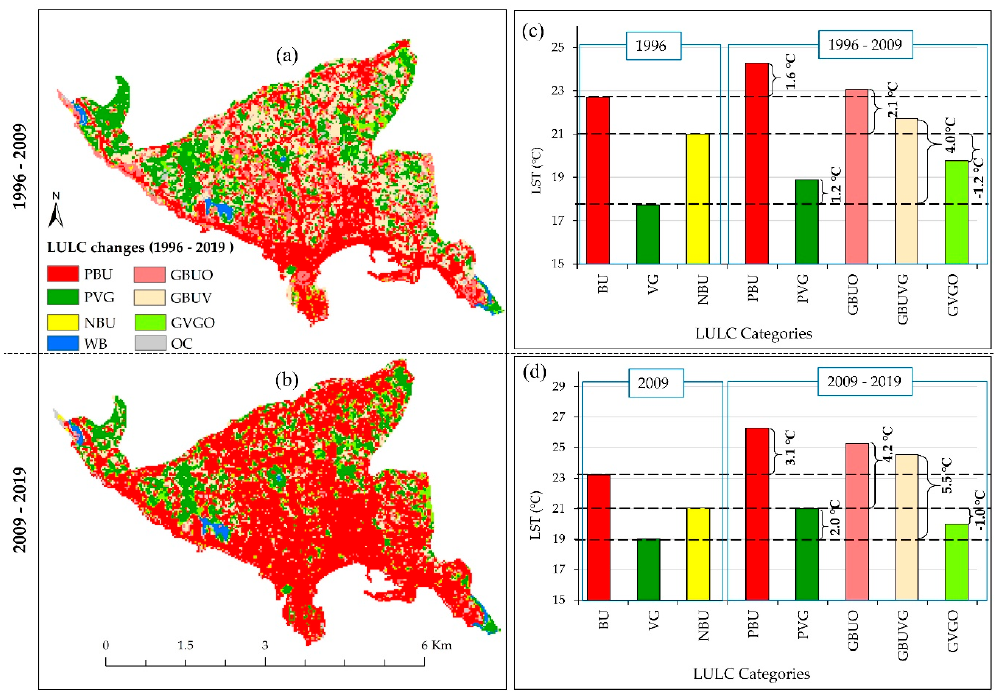
Figure 4. LST variation and its different contribution by LULC categories: ( a ) LULC changes from 1996 to 2009, ( b ) LULC changes from 2009 to 2019, ( c ) LST variations on changes land from 1996 to 2009 and its temporal comparison with 1996, and ( d ) LST variations on changes land from 2009 to 2019 and its temporal comparison with 2009. PBU, persistent built-up; PVG, persistent vegetation; NBU, non-built-up; WB, waterbody; GBUO, gain of built-up from others; GBUVG, gain of built-up from vegetation; GVGO, gain of vegetation from others; OC, other changes; BU, built-up; VG, vegetation.